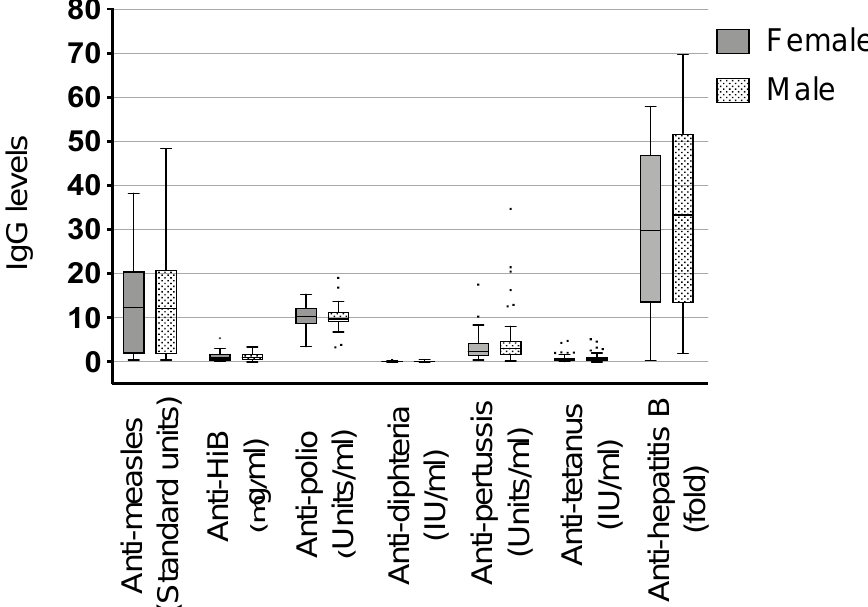
Figure 3. Comparison of immunoglobulin (Ig) G to expanded program of immunization (EPI) vaccines between female and male infants. Dots represent the outliers not removed by ROUT method.